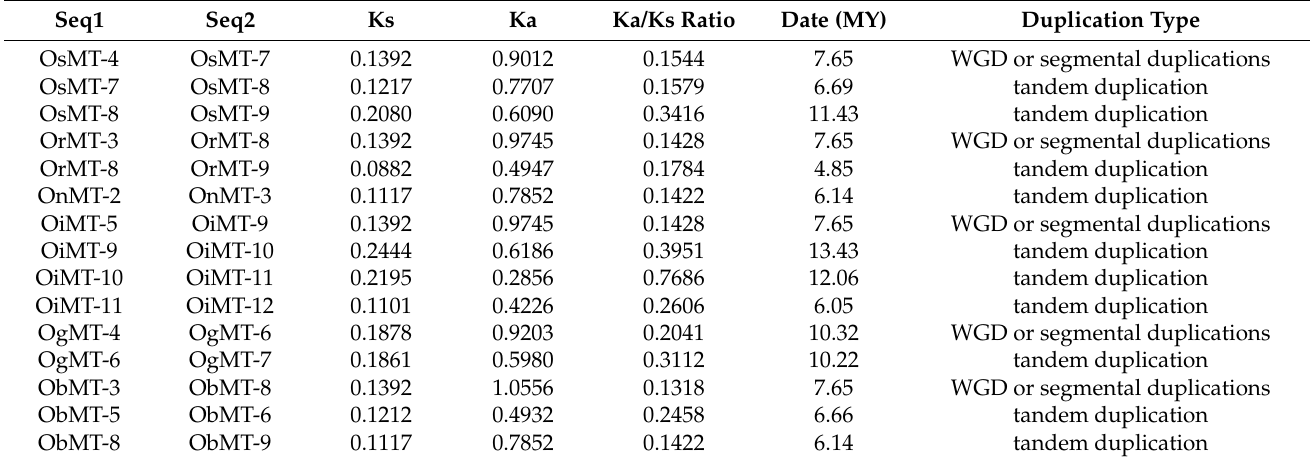
Figure 3. The chromosome location and duplication events of MT genes in six species/subspecies. Os represents Oryza sativa ssp. japonica . Or represents Oryza rufipogon . On represents Oryza nivara . Oi represents Oryza sativa ssp. indica . Og represents Oryza glumaepatula . Ob represents Oryza barthii . The location of each MT gene is marked with a gray line using Circos software. The whole- genome duplication (WGD) or segmental duplication/tandem duplication gene pairs are linked by red/blue lines. Table 1. Ka, Ks, and Ka/Ks values for duplicated gene pairs in